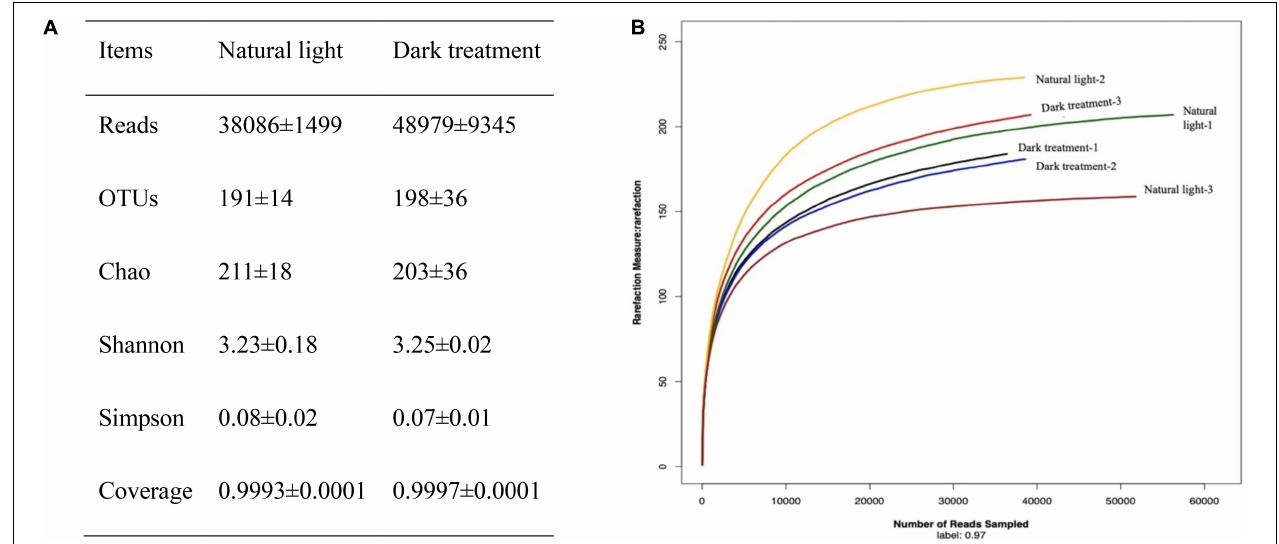
FIGURE 6 | Characteristics of sequencing results. (A) Summary of sequencing data and (B) rarefaction analysis. Rarefaction curves of OTUs clustered at 97% sequence identity across the sample. The samples labeled with natural light-1, natural light-2, and natural light-3 corresponded to three replicates of the natural light group; the samples labeled with dark treatment-1, dark treatment-2, and dark treatment-3 corresponded to three replicates of the dark treatment